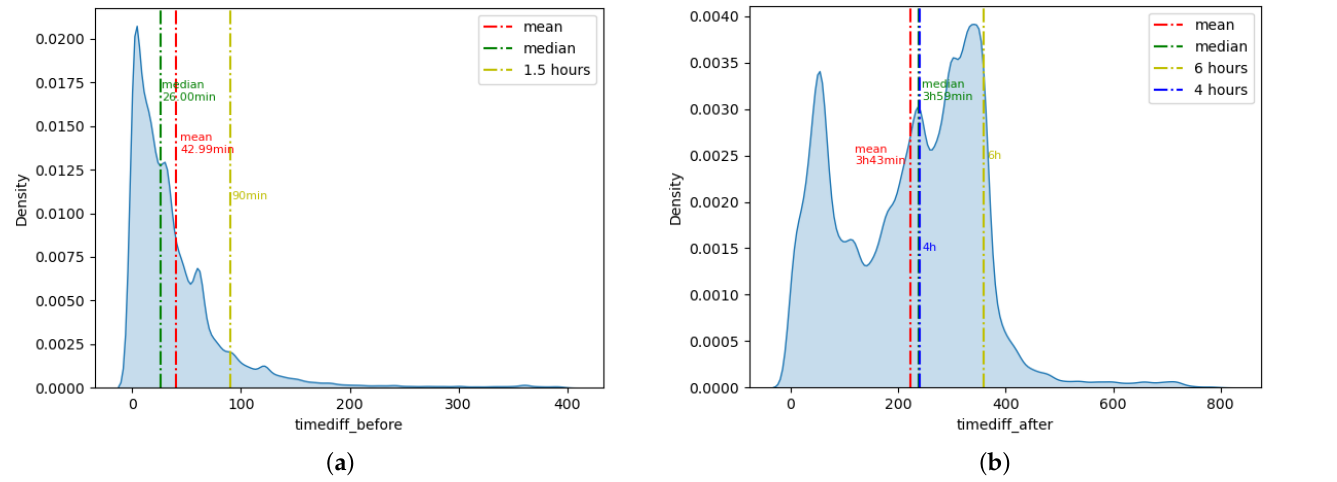
Figure 2. ( a ) Probability density diagram of timediff_before. ( b ) Probability density diagram of